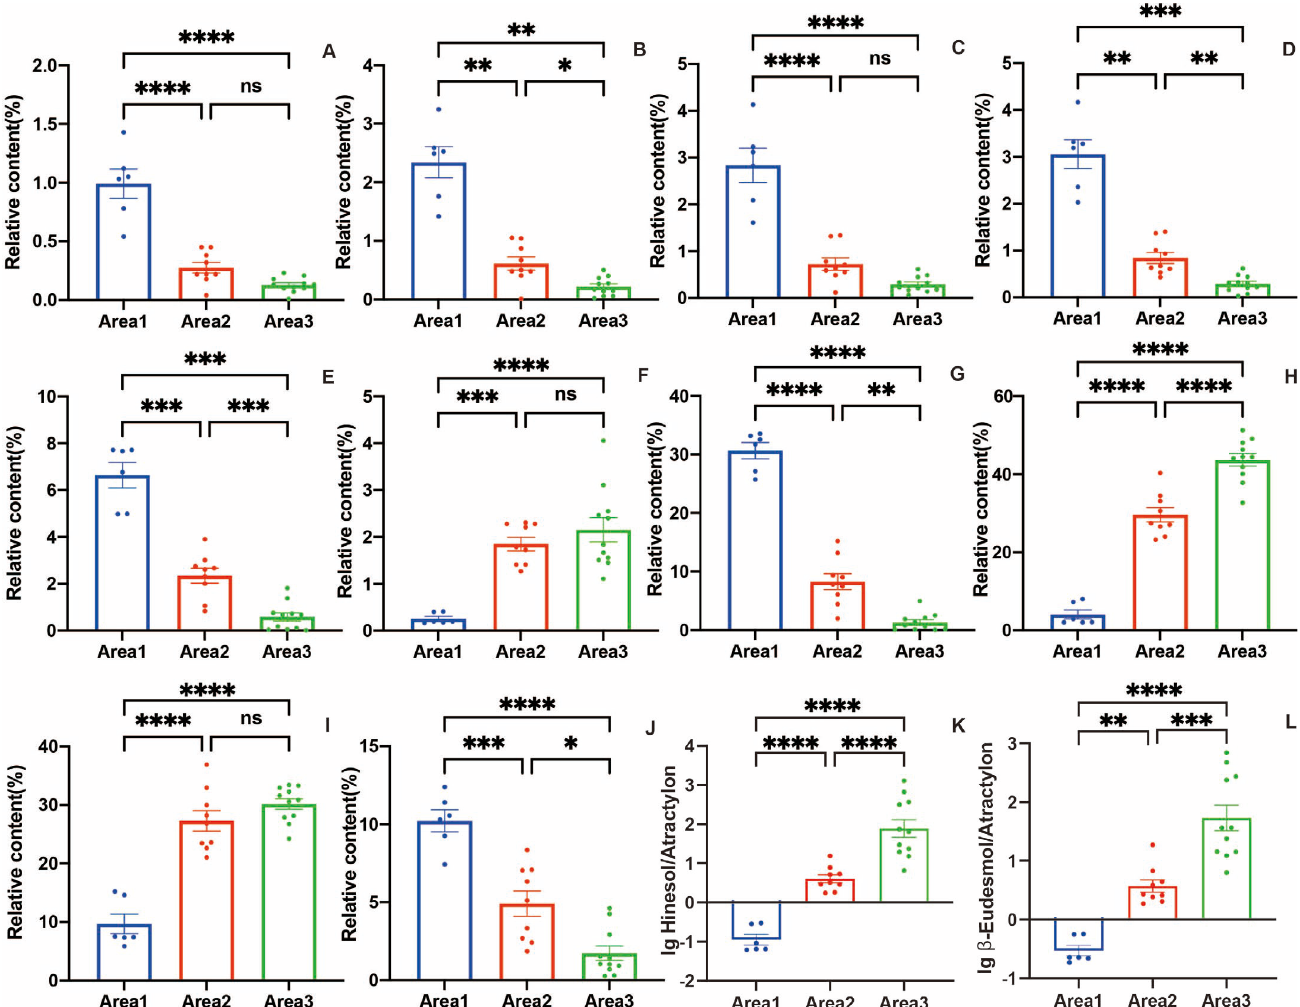
Figure 6. Relative contents of the characteristic composition in total ion chromatography (TIC) of area 1, area 2, and area 3. ( A ) α -guaiene; ( B ) modephene; ( C ) berkheyaradulene; ( D ) caryophyllene; ( E ) γ -elemene; ( F ) elemol; ( G ) atractylon; ( H ) hinesol; ( I ) β -eudesmol; ( J ) atractylodin; ( K ) lg hinesol/atractylon; ( L ) lg β -eudesmol/atractylon. Data were shown as mean ± SEM. **** p < 0.0001, *** p < 0.001, ** p < 0.01, * p < 0.05, ns was considered as no significant difference.